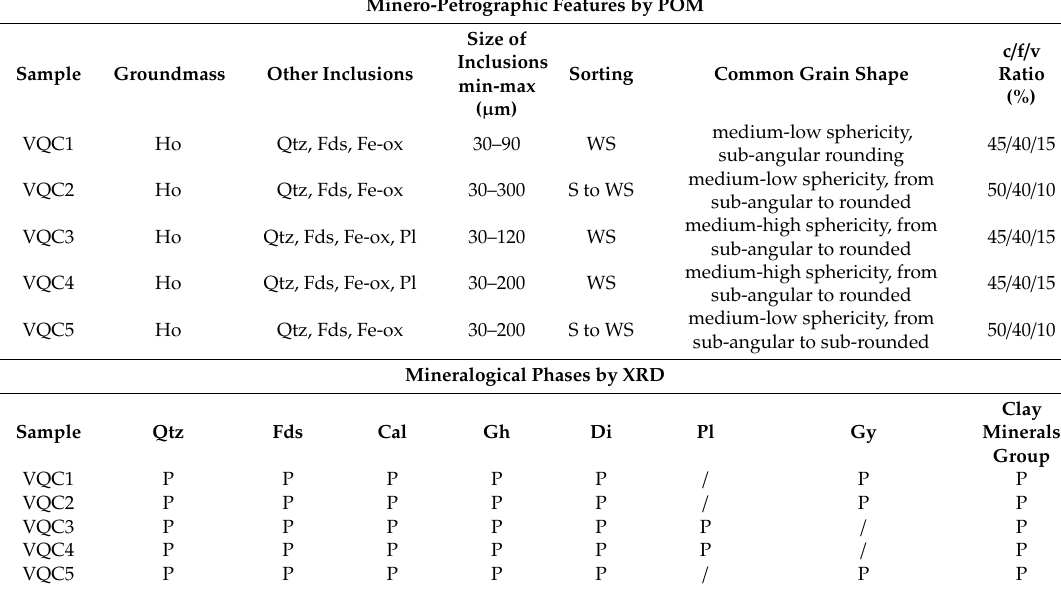
Table 2. Main minero-petrographic features of investigated samples as obtained by polarising optical microscopy (POM) and XRD. Notes: Cal = calcite; Di = diopside; Fds = feldspars; Fe-ox = iron oxides; Gh = gehlenite; Gy = gypsum; Pl = plagioclase; Qtz = quartz; Ho = homogeneous; WS = well-sorted; S = sorted; P = present; / = absent; c / f / v = the ratio of coarse, fine, and void components of the fabric